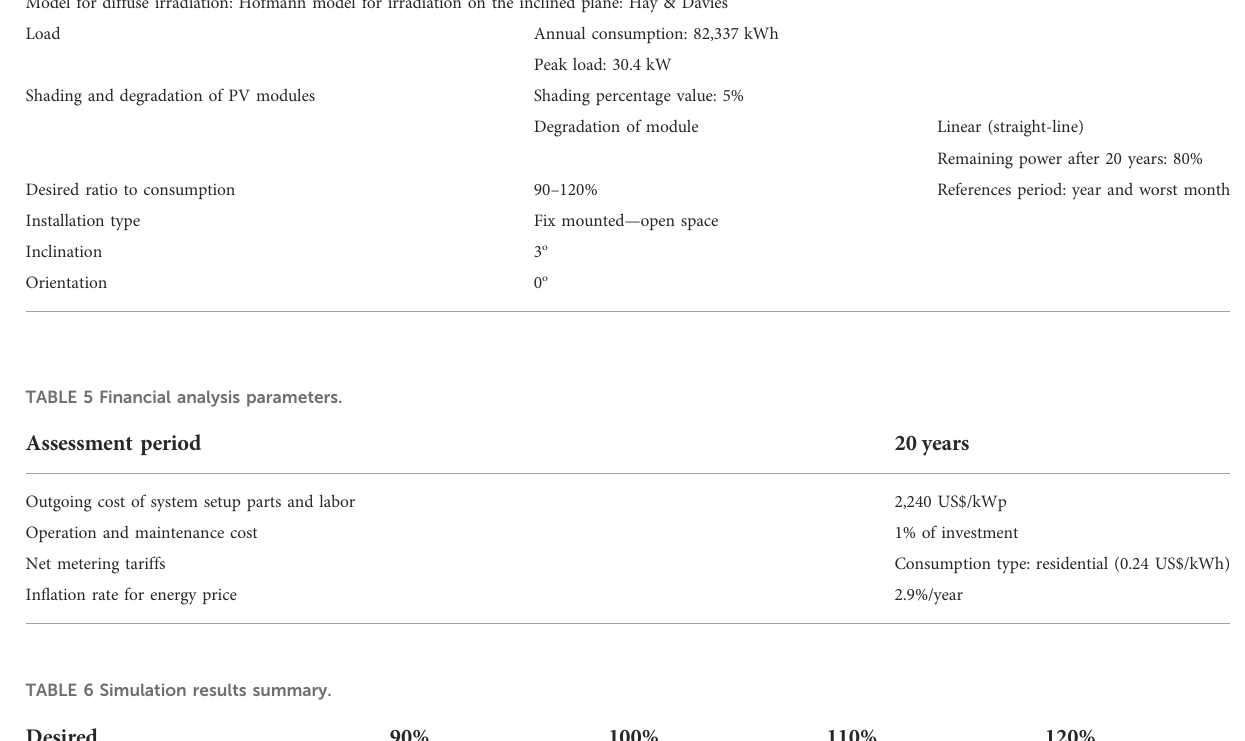
TABLE 6 Simulation results